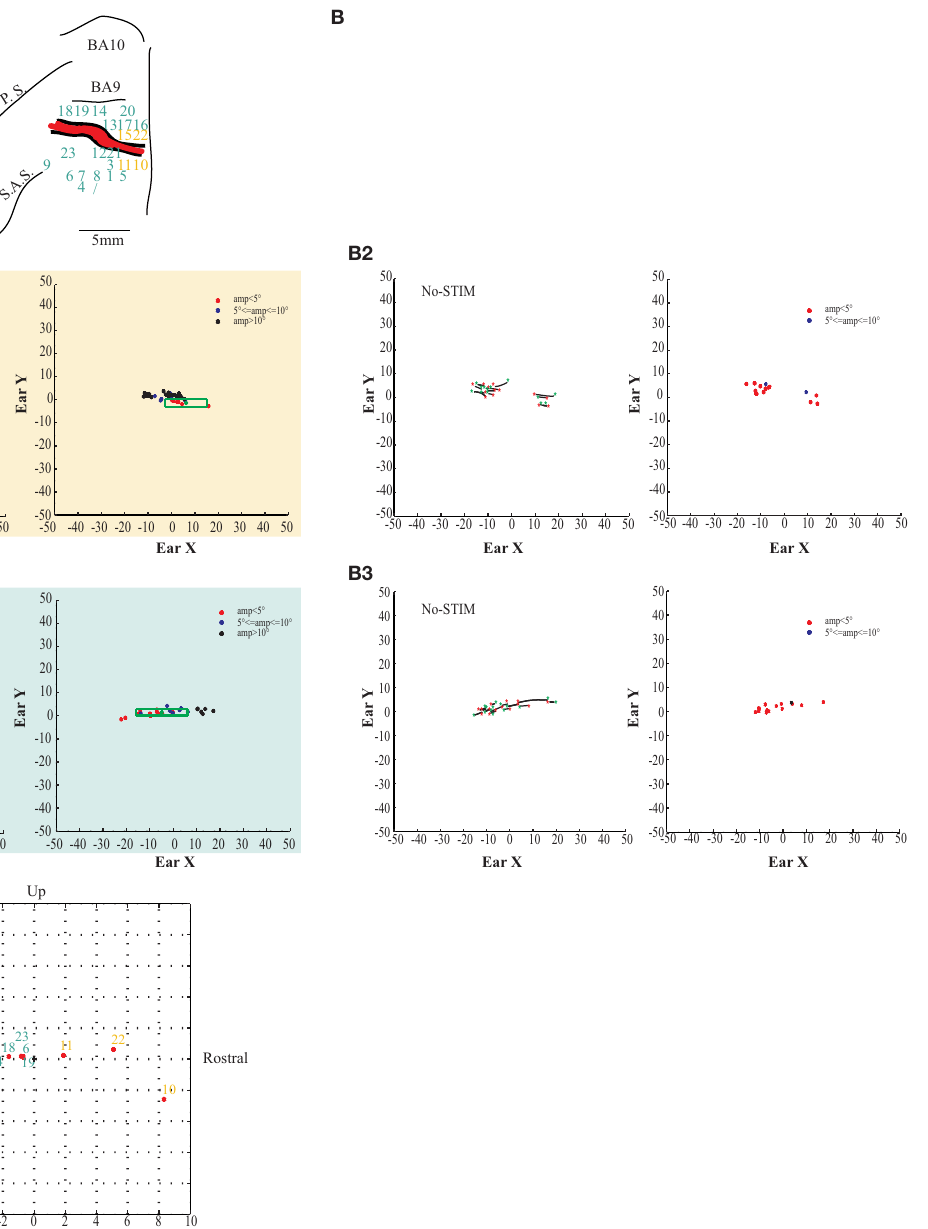
(A4) Plot shows the averaged end-points, for each penetration, relative to a common starting position. Numbers indicate the electrode penetrations. End-points which have positive values on x-axis indicate forward ear movements. End-points which have negative values on x-axis indicate backward ear movements. (B) The figures show self-generated ear movements. (B2) The plots show self-generated ear movements sampled outside the stimulation period and from the same experimental session of panel (A2) . The plot on the left shows the direction of the ear movements. The plot on the right shows the relationship between starting position and movement amplitude. (B3) The plots show self-generated ear movements sampled outside the stimulation period and from the same experimental session of panel (A3) . The plot on the left shows the direction of the ear movements. The plot on the right shows the relationship between starting position and movement